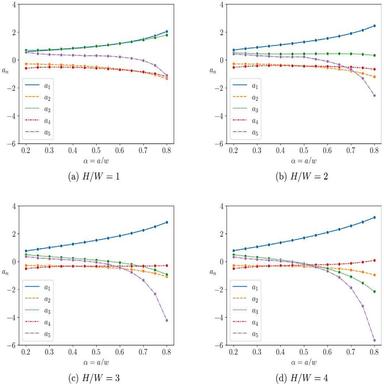
Normalized Williams coefficients 1 , … , 5 for the SECT-specimen parameter study over the whole crack length and for several ∕ ratios.